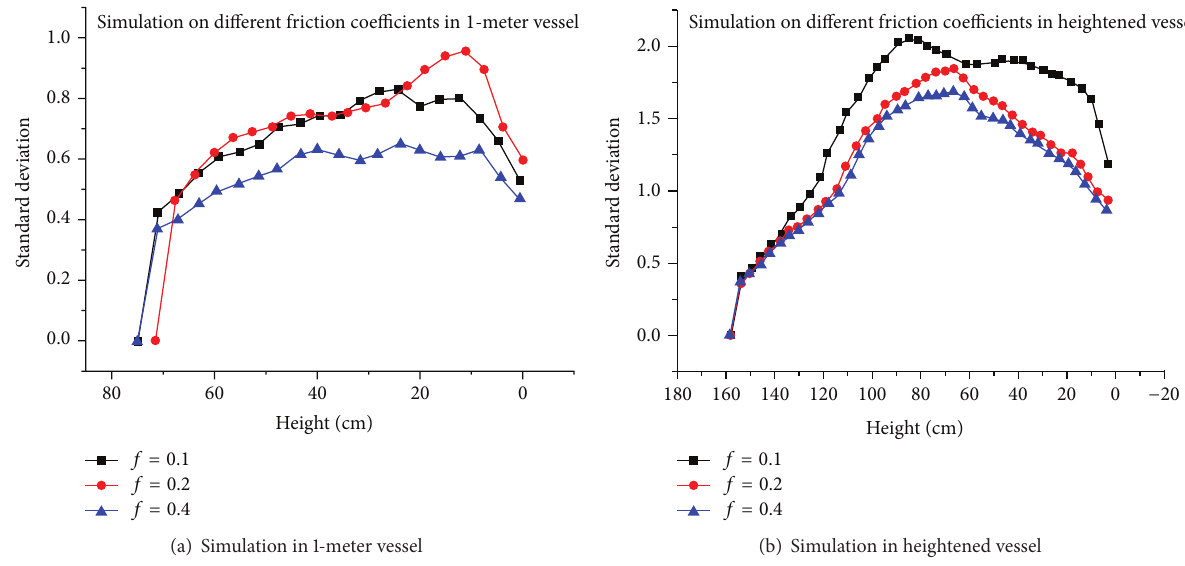
Figure 12: Simulations on different friction coefficients in 1-meter and heightened